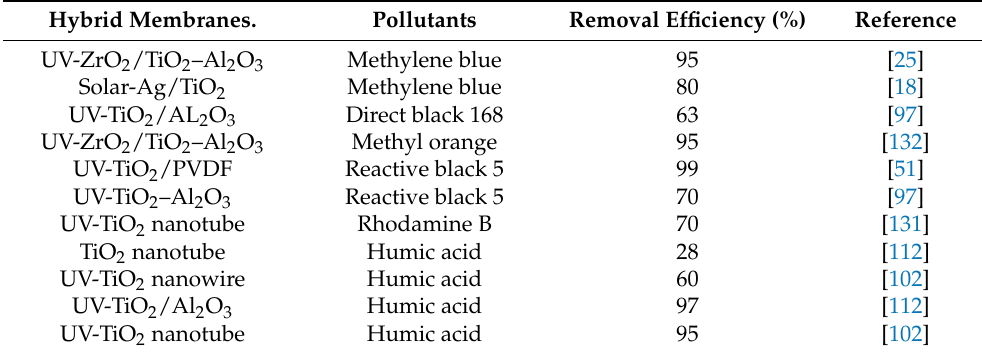
Table 9. Application of TiO 2 -based membranes in wastewater settings. Hybrid